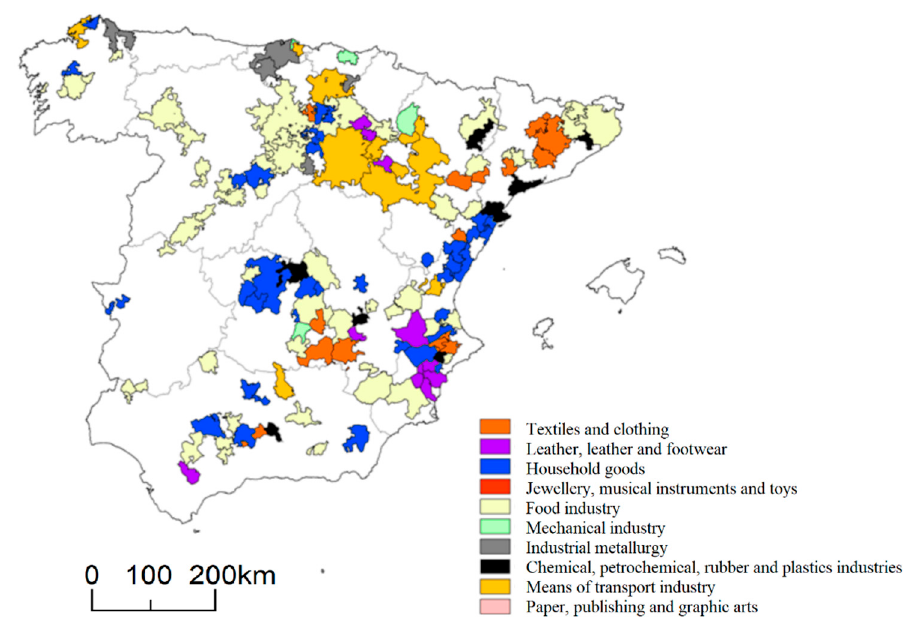
Figure 2. A general map identifying and classifying industrial districts in Spain (2011). Source: Own elaboration from [44].